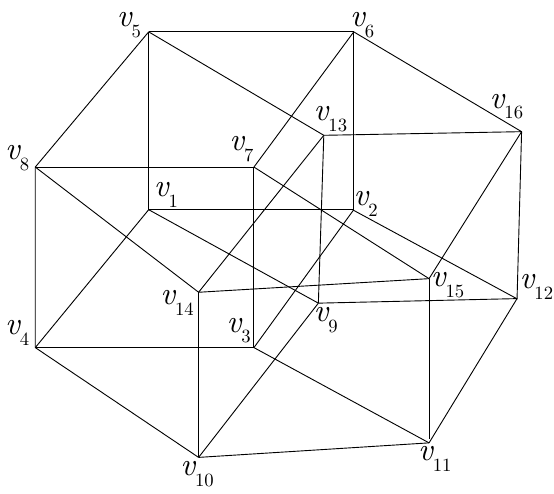
, for the elliptic Calabi-Yau fivefold with 8